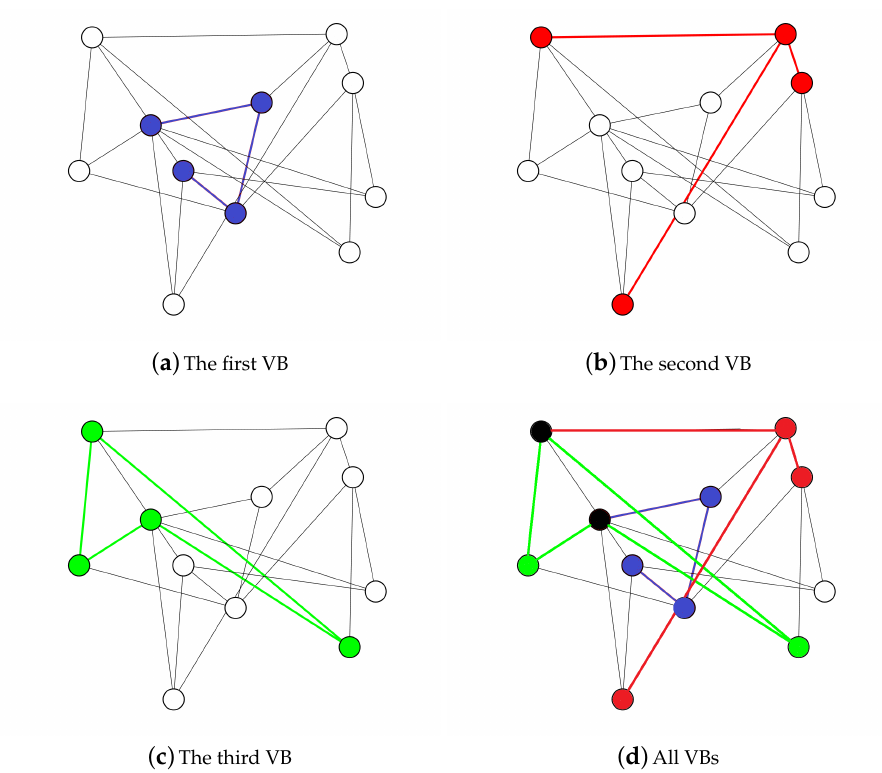
Figure 15. N 1 with three virtual